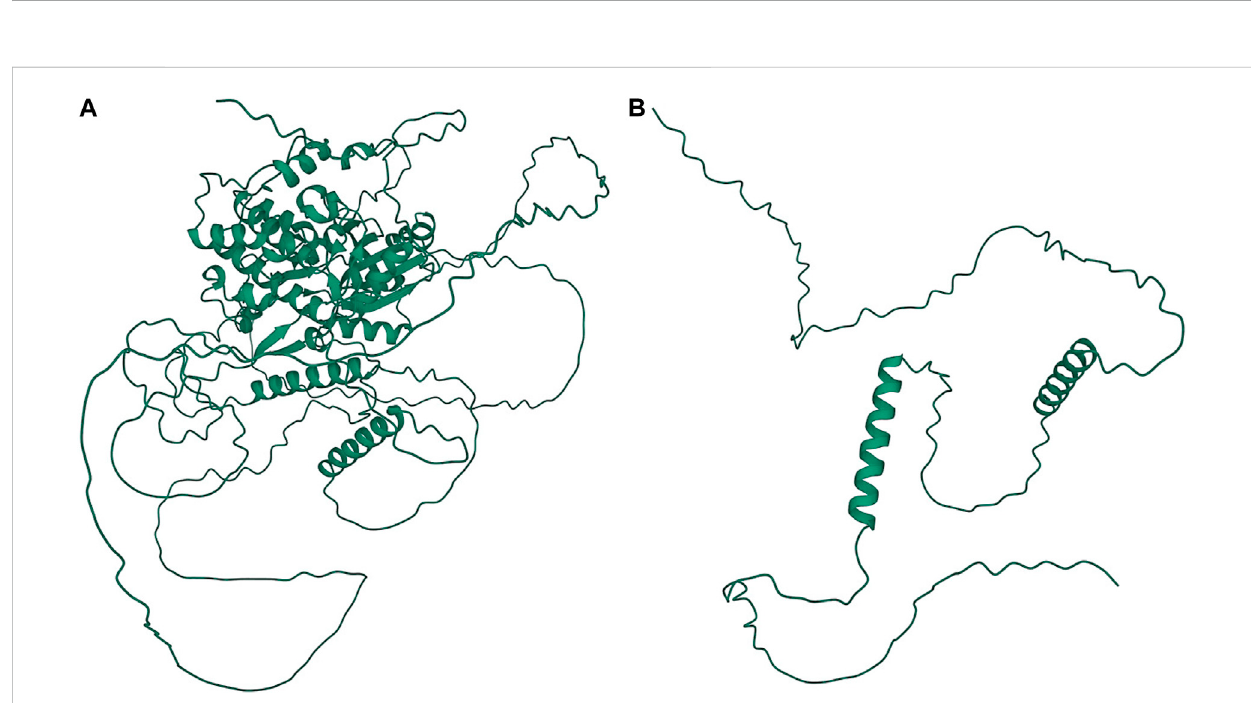
FIGURE 5 Protein structures predicted for Dw2 using AlphaFold two for both the (A) annotated protein and (B) truncated protein. Protein coils represent α helices and arrows represent β -pleated